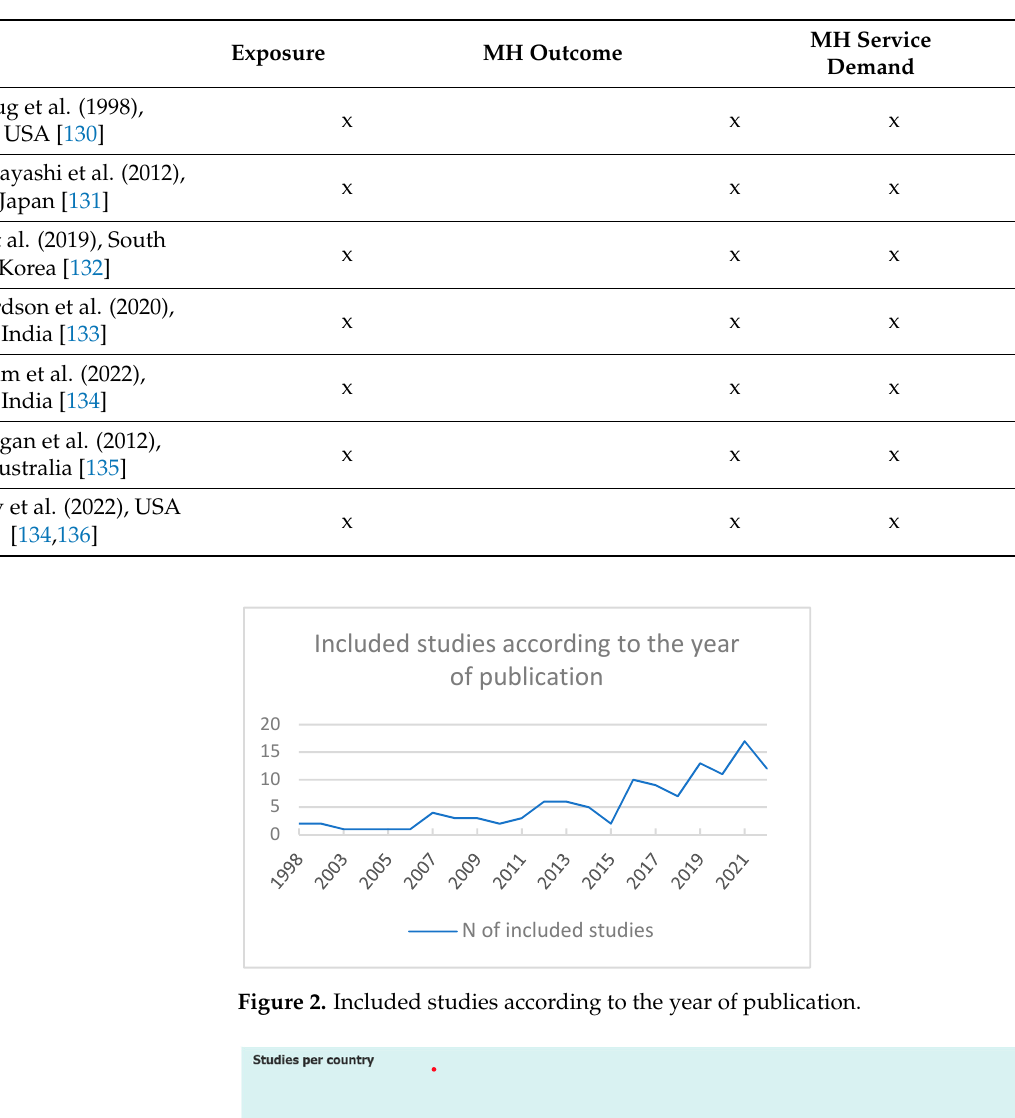
lance dispatch, outpatient visits, and other types of provided healthcare were poorly re- searched ( n = 10) and could, in the future, receive more focus from science. In addition, no significant difference among them was found, and it seems that healthcare services are equally demanded. Figure 4 lists the measure of effect and displays them according to the used service.